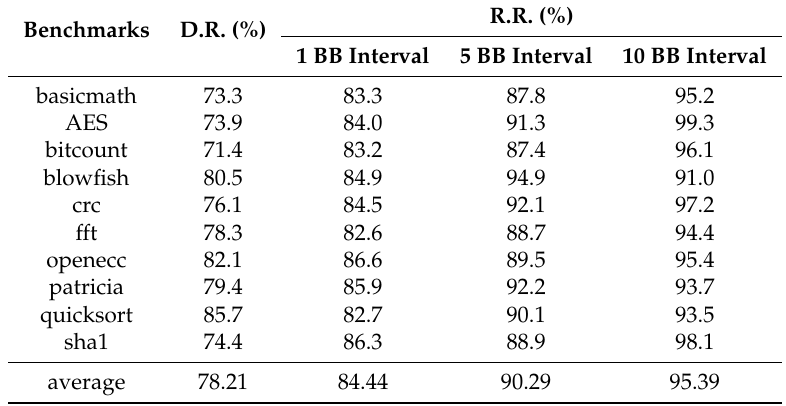
Table 3. Detection and recovery rating for buffer overflow on current stack frame.